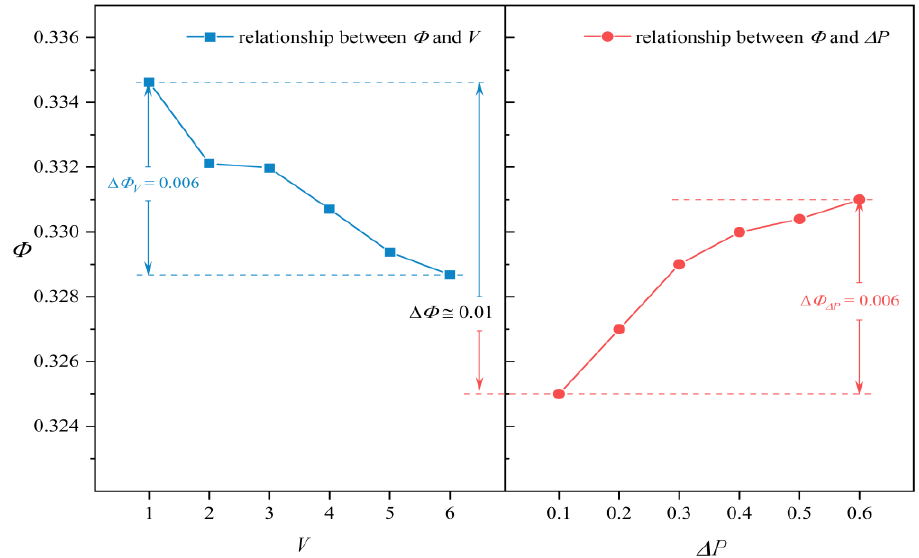
Figure 4. Influence of V and ∆ P on Φ .